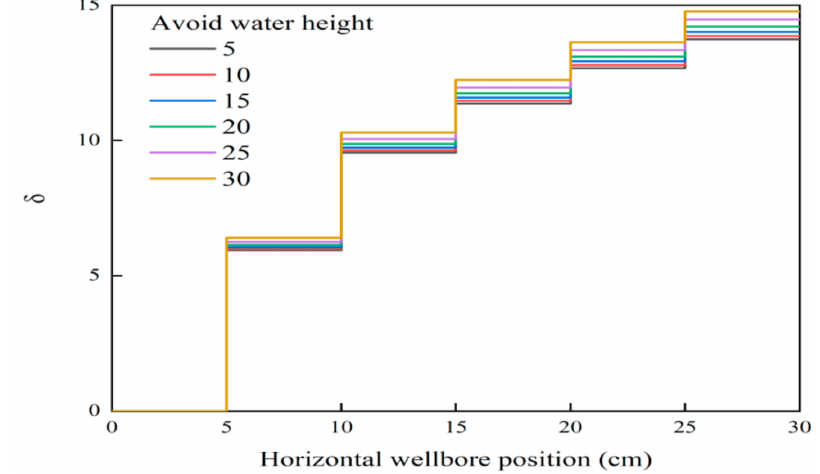
Figure 6. Distribution of δ along the horizontal well at different water shelter